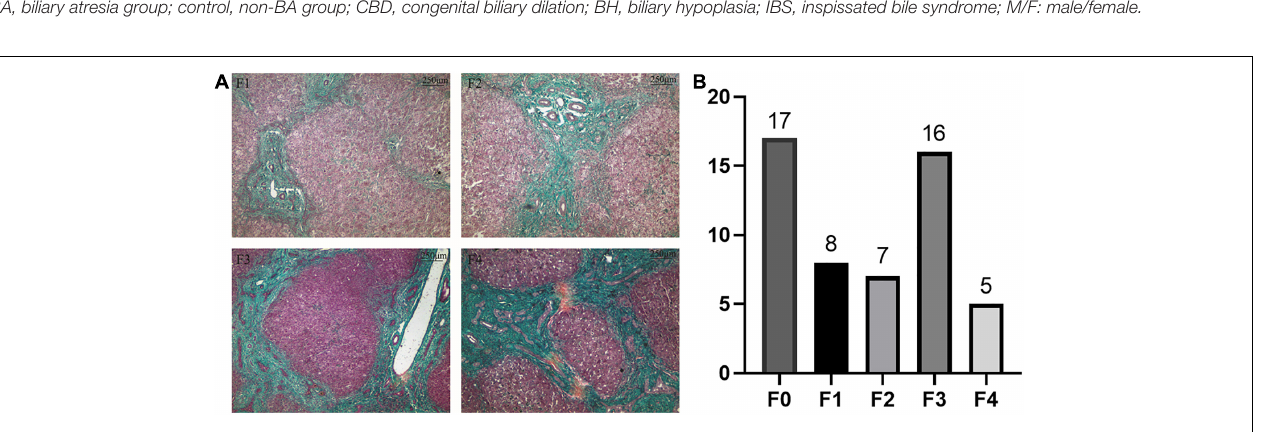
FIGURE 1 | (A) Masson staining in liver tissues of patients with BA. (B) The distribution of liver fibrosis. (A) Liver fibrosis levels were accessed by Masson staining. Collagen fibers are blue, and cytoplasm is red. F1: portal fibrosis without linkage; F2: fibrous septa portal-to-portal; F3: fibrous septa portal-to-portal and portal-to-central; and F4: cirrhosis. (B) The distribution of liver fibrosis levels in 53 patients. Including 17 cases with F0 (no fibrosis), eight cases with F1, seven cases with F2, 16 cases with F3, and five cases with